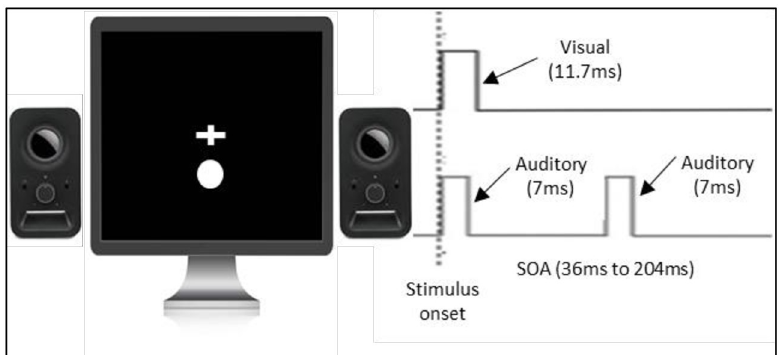
Fig 6. Paradigm of the double-flash illusion